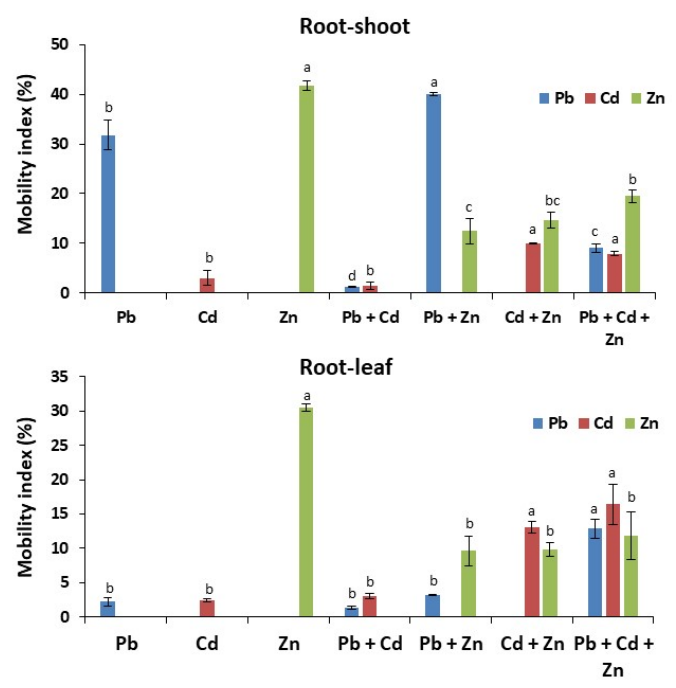
Figure 1. Mobility index (%) of Pb, Cd, and Zn from roots to shoots and roots to leaves in response to Pb / Cd / Zn applied alone and in combinations. The values marked with di ff erent letters are statistically di ff erent ( p ≤ 0.05), while the values marked with the same letters do not di ff er significantly.